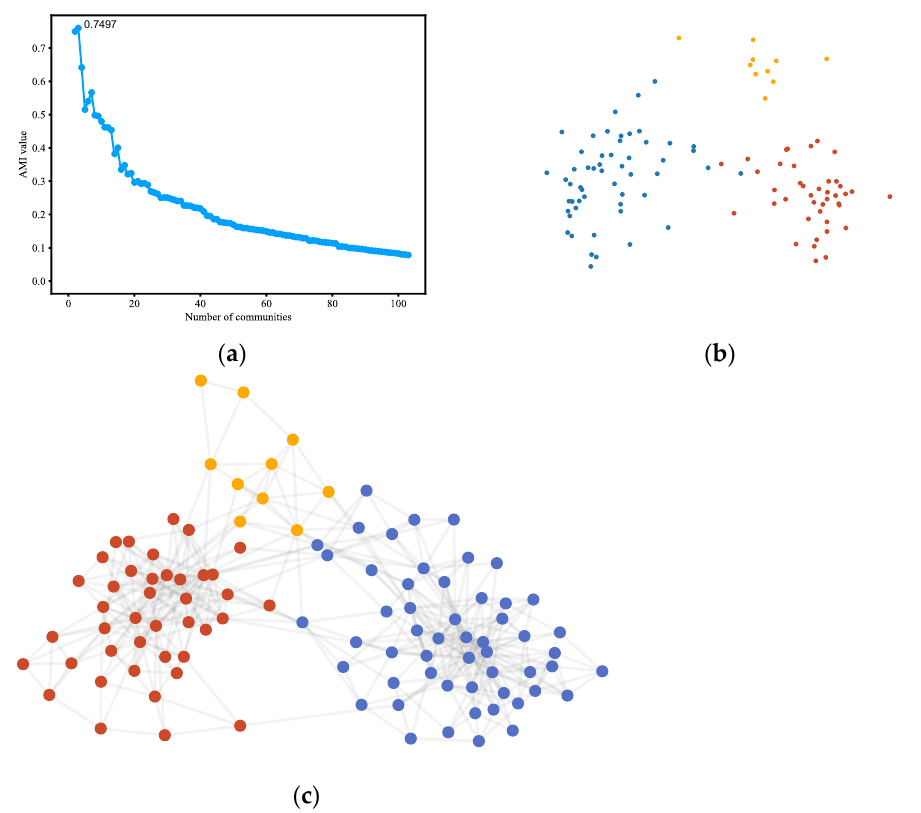
Figure 4. ( a ) AMI variation graph of adjacent partitions of Polbooks. ( b ) Vectors representing each node of Polbooks. ( c ) Result of community detection on Polbooks.